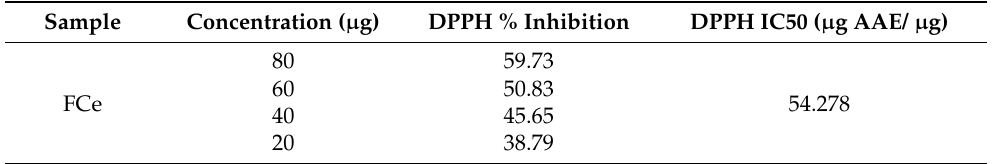
Table 2. The percent DPPH free radical scavenging activity of the FCe using ascorbic acid as the standard.